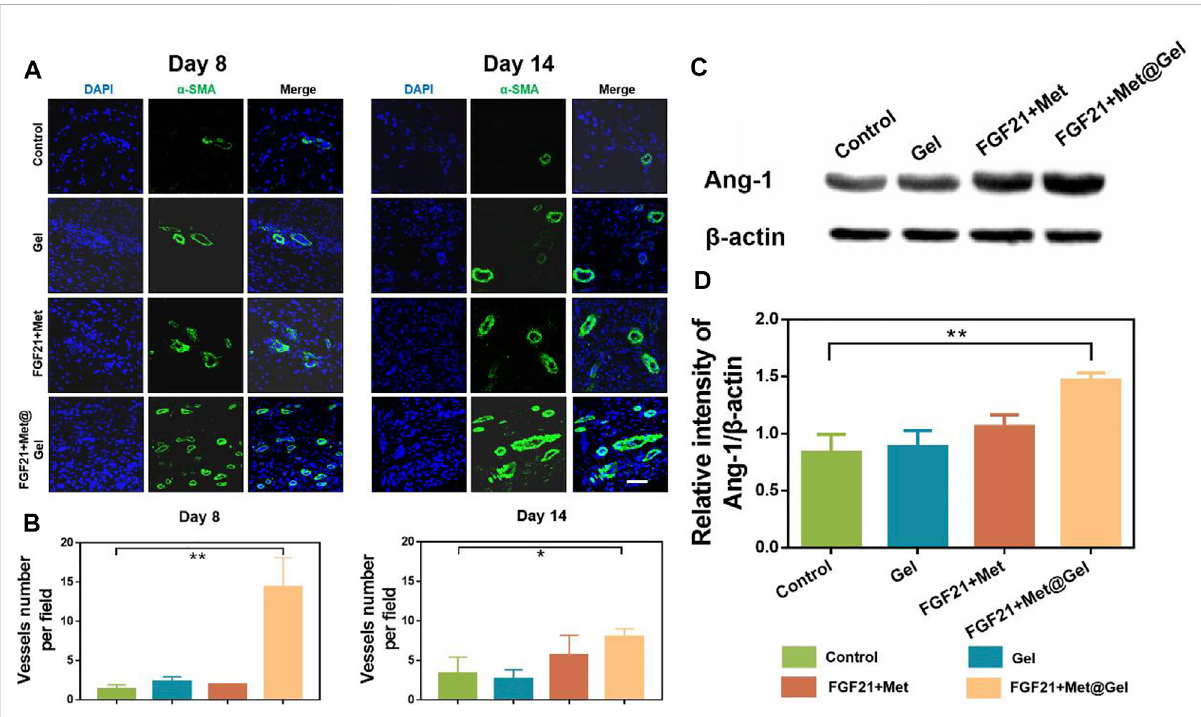
FIGURE 7 (A) Immuno fl uorescencestainingof α -SMA(green)ofwoundtissuesondays8and14(scalebars:50 μ m). (B) Quanti fi eddataofvesselsnumber per fi eld. (C) Western blot analysis of Ang-1 expression. (D) Quantitative analysis of Ang-1 protein expression based on Western blot. *p < 0.05; **p < 0.01 compared with control, n =